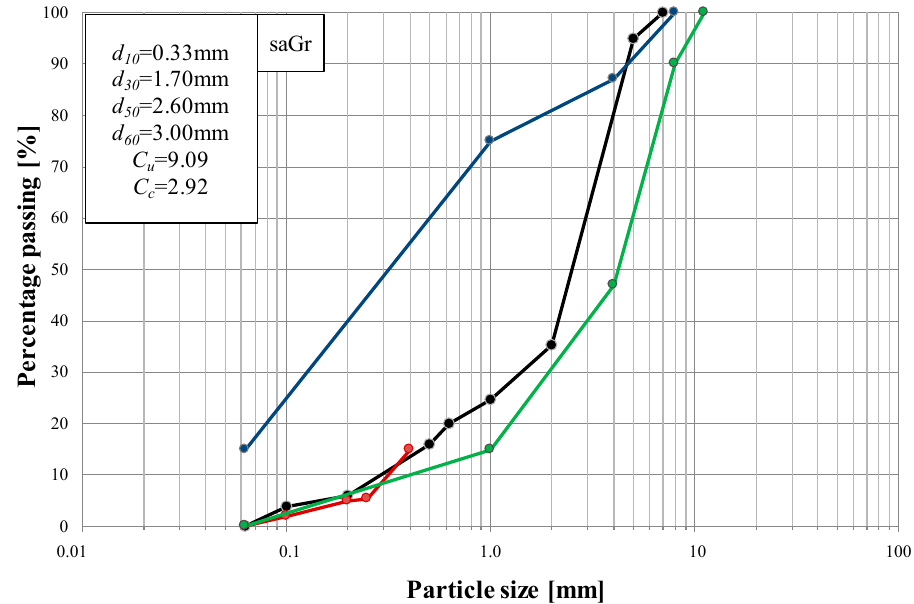
Figure 3. Particle size distribution of RCA and rubber chips (black line: pure RCA, red line: rubber chips, blue line: upper limit by WT-4 [41], green line: lower limit by WT-4 [41]).